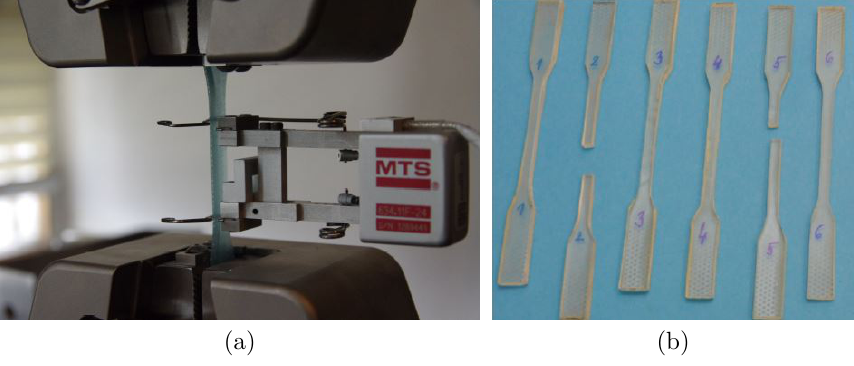
Figure 1. Cross section of examined fibrous composite.